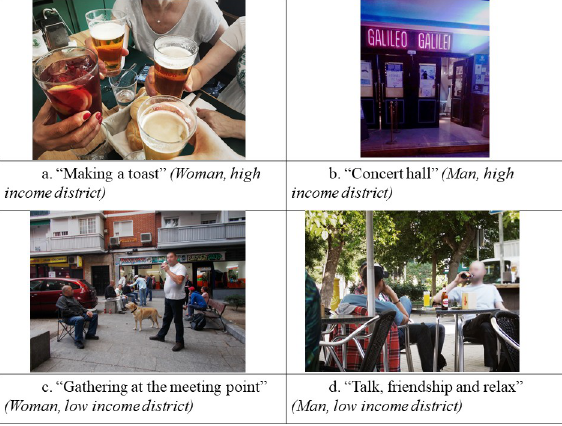
Fig 2. Photographs on the social role of alcohol.